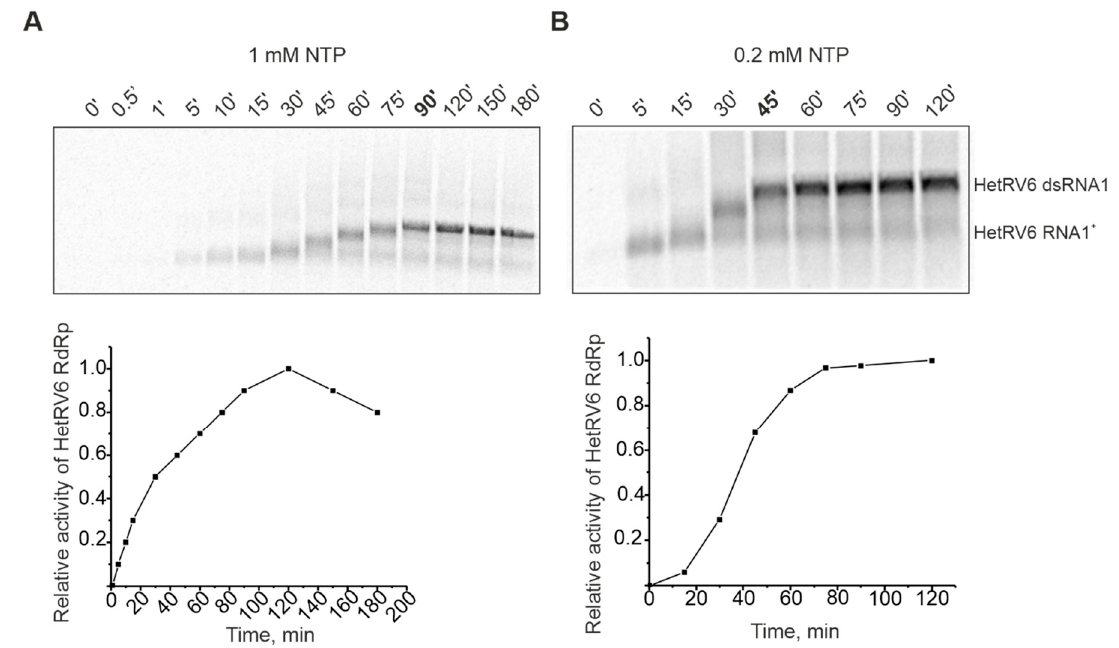
Figure 3. Time course of dsRNA synthesis catalyzed by HetRV6 RdRp in the presence of 1 mM ( A ) and 0.2 mM ( B ) NTPs. A 150-µL polymerase reaction containing HetRV6 RNA1 + was incubated at 30 °C in the presence of HetRV6 RdRp. Five microliter aliquots, sampled at the indicated time points, were analyzed by agarose gel electrophoresis followed by autoradiography. Representative autoradiography images of the sample analysis (upper panel) and graphical presentation of the same data (lower panels) are shown. Quantitation of the full-length dsRNA product was done by densitometry with Fiji image analysis software (see Section 2.6). The data were normalized so that the highest observed value for the density of dsRNA band on each panel was set to 1.0. The mobility of the template HetRV6 RNA1 + and the dsRNA product are indicated on the right.